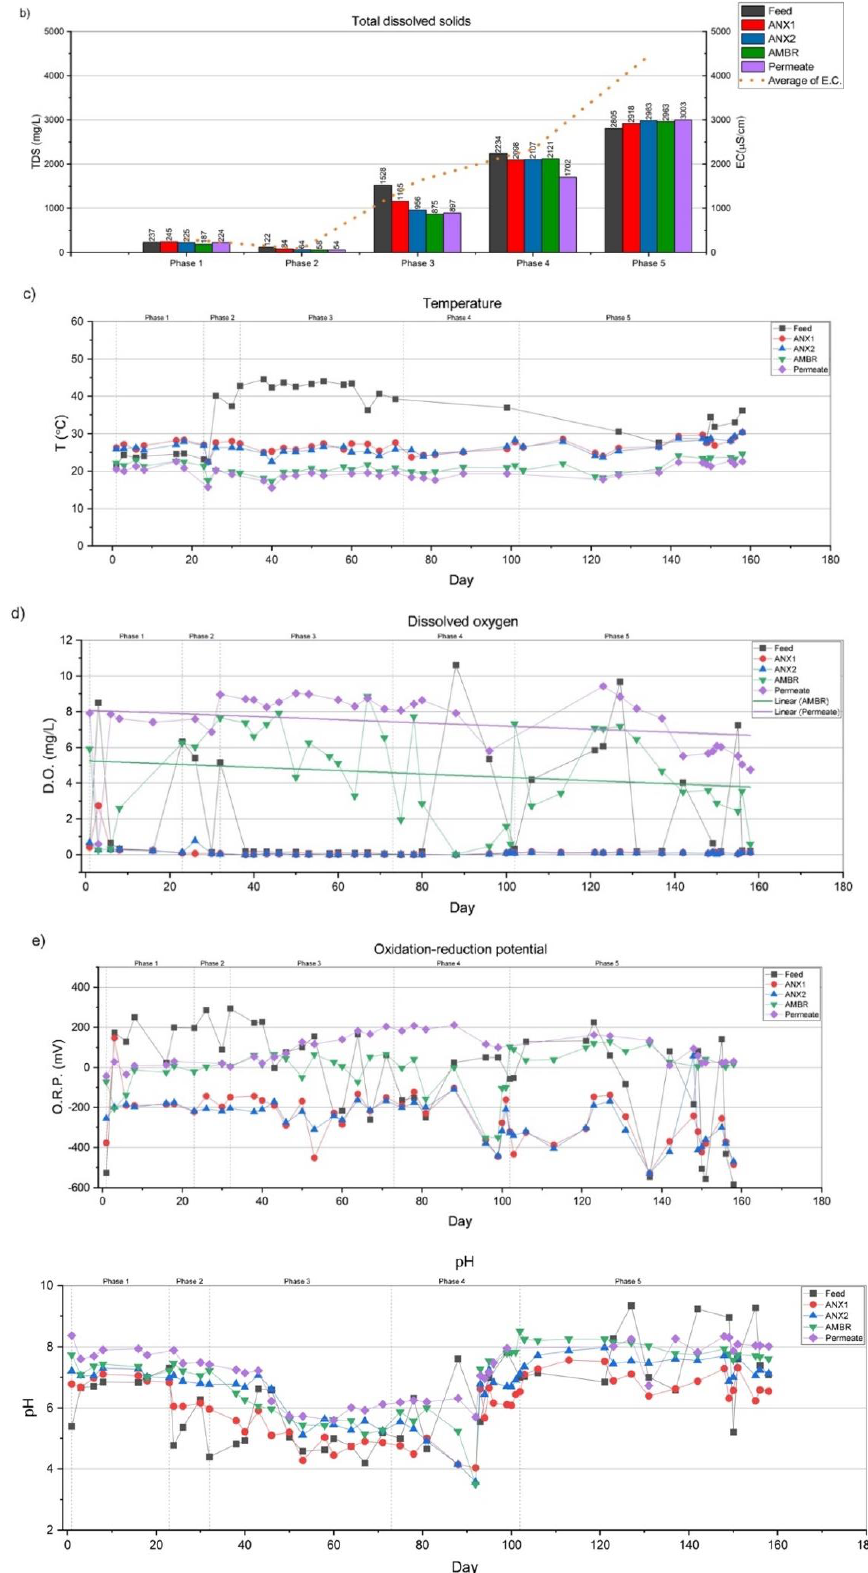
Figure 2. Monitoring of temporal variations of different water quality parameters during the entire experimental duration. ( a ) electrical conductivity, ( b ) total dissolved solids, ( c ) temperature variation, ( d ) dissolved oxygen, ( e ) oxidation-reduction potential, ( f ) hydrogen potential